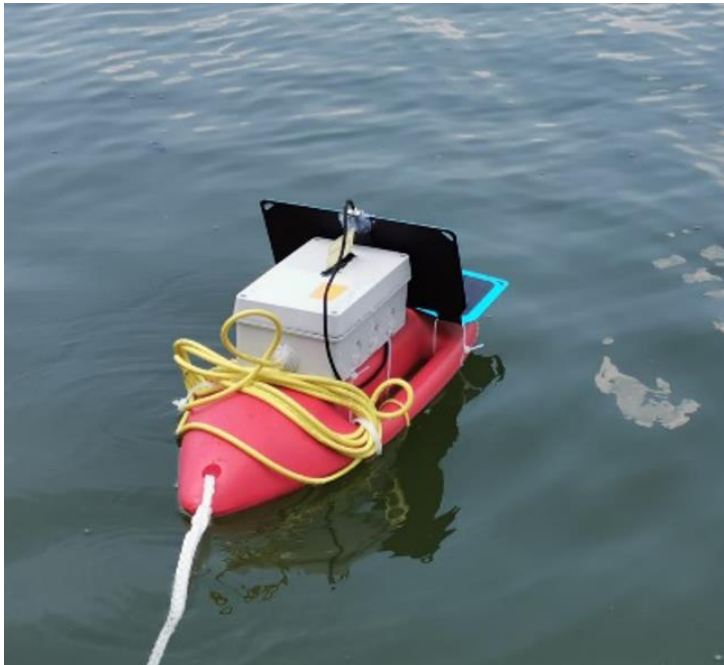
Figure 35. A beacon deployed in its operating environment.